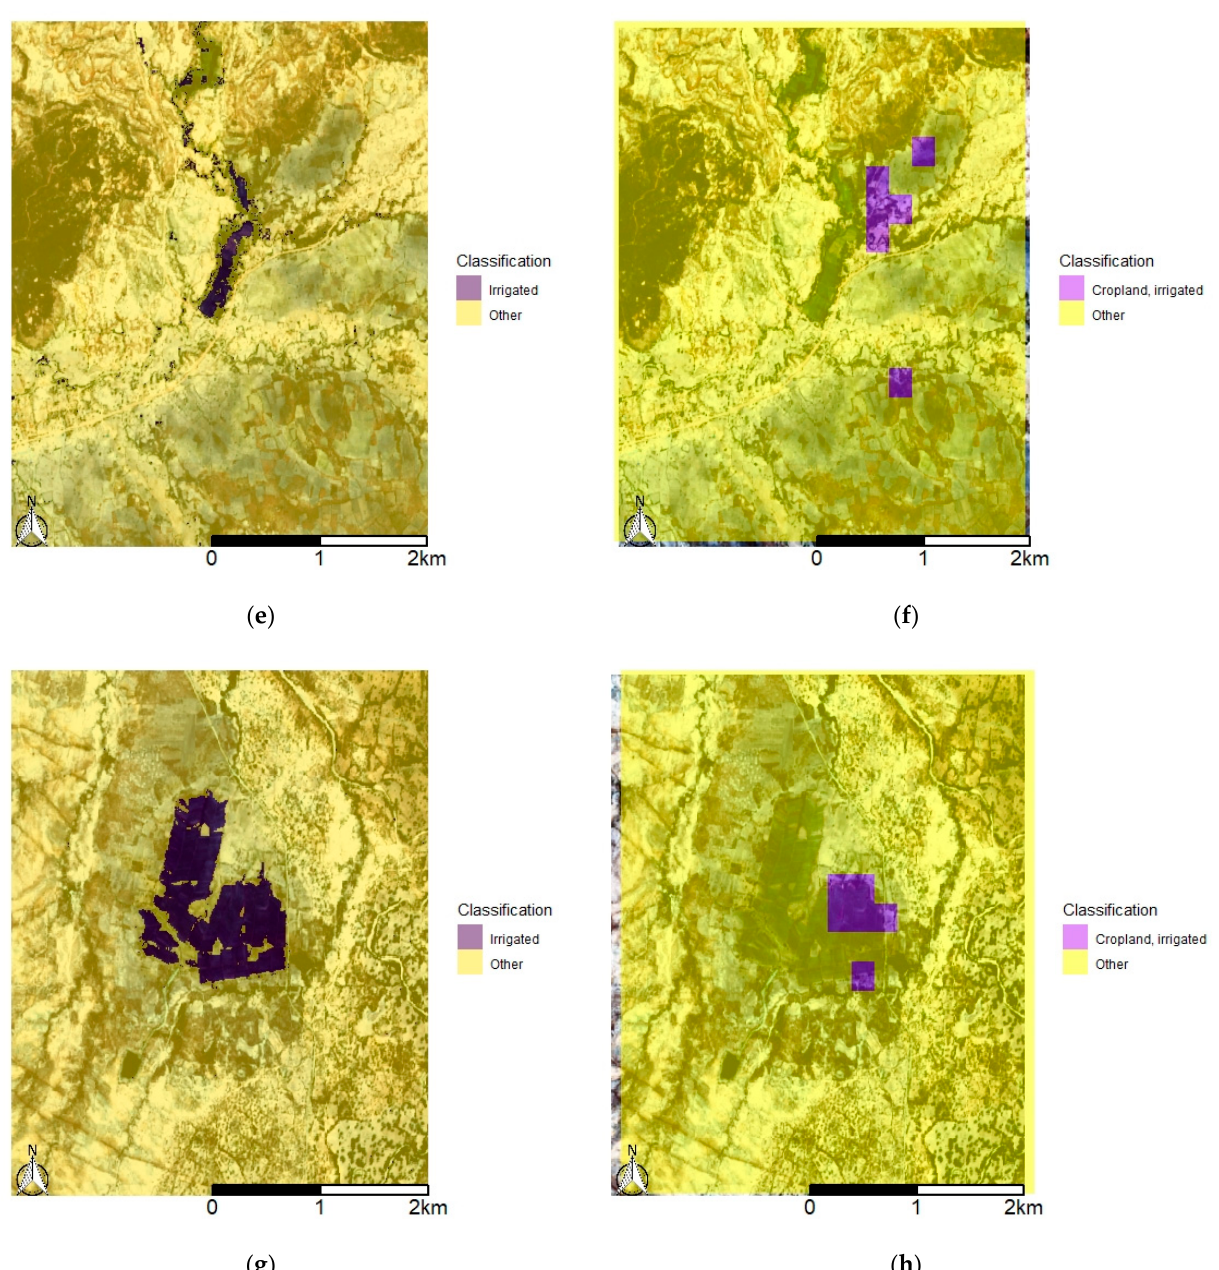
Figure 6. True color geomedian composites overlaid with a transparent layer showing classification results for the random forest models trained on annual datasets for ( a ) the Ord River Irrigation Area, compared with ( b ) AQUASTAT’s Global Map of Irrigated Areas [37]. Transparent classification layers over true color geomedian composites derived from Sentinel-2 data for ( c ) Silalatshani, ( e ) Nabusenga, and ( g ) Lungwalala are compared with Water Productivity through Open access of Remotely sensed derived data (WaPOR) [40] classification ( d , f , h ) .